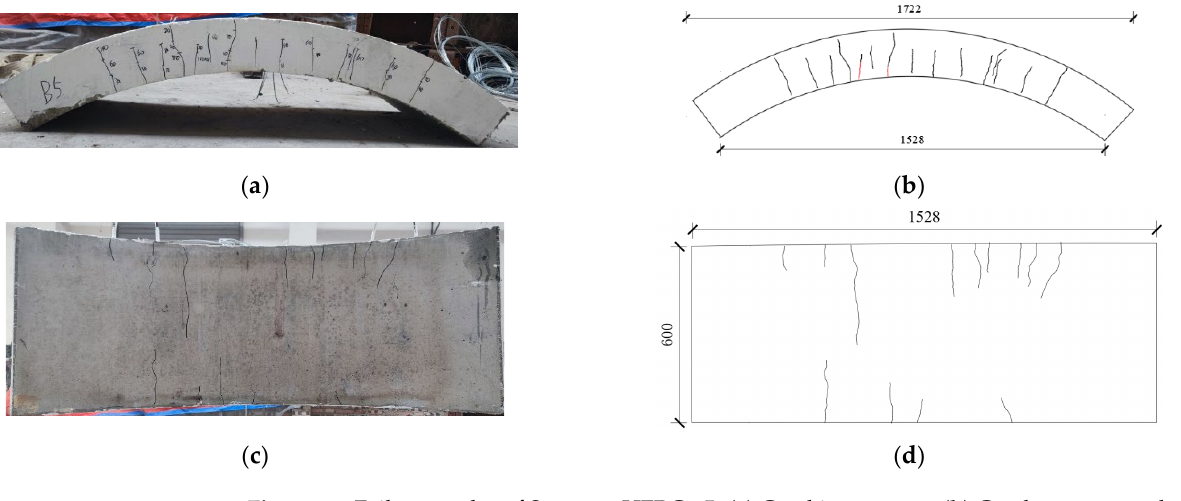
Figure 11. Failure modes of Segment HFRC − 5: ( a ) Cracking pattern; ( b ) Crack pattern on the side surface; ( c ) Bottom surface; and ( d ) Cracking pattern on the bottom surface.